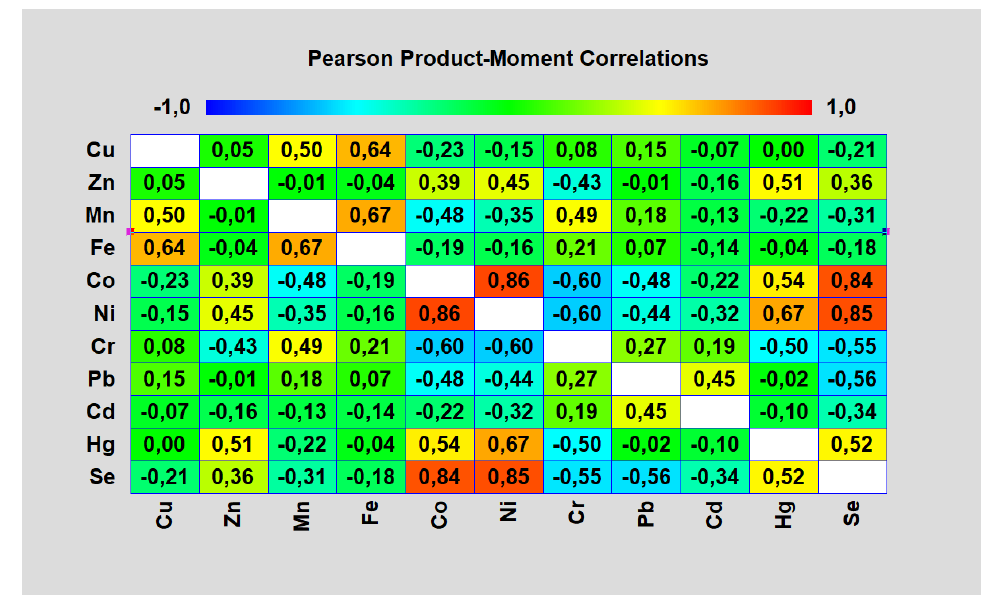
Table 6. Average metals content (mg.kg −1 DM) in samples of fortified fruiting bodies with selenium . Pleurotus ostreatus strain 2-’Kryos B´—The Content of Selected Metals mg.kg −1 DM